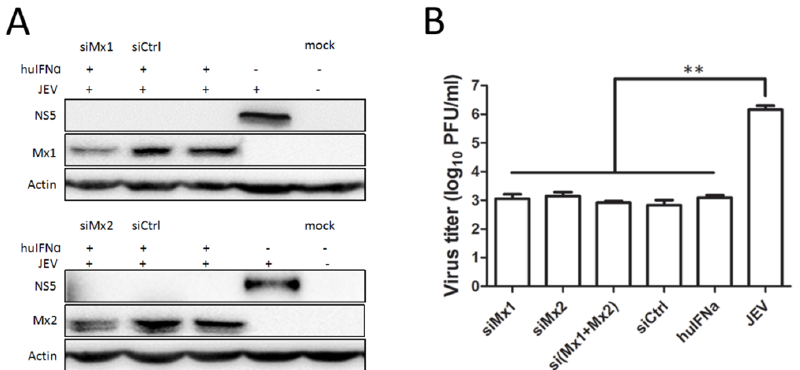
Figure 6. IFN α inhibits JEV replication in Mx ‐ knockdown PK ‐ 15 cells. Mx1 and Mx2 knockdown in